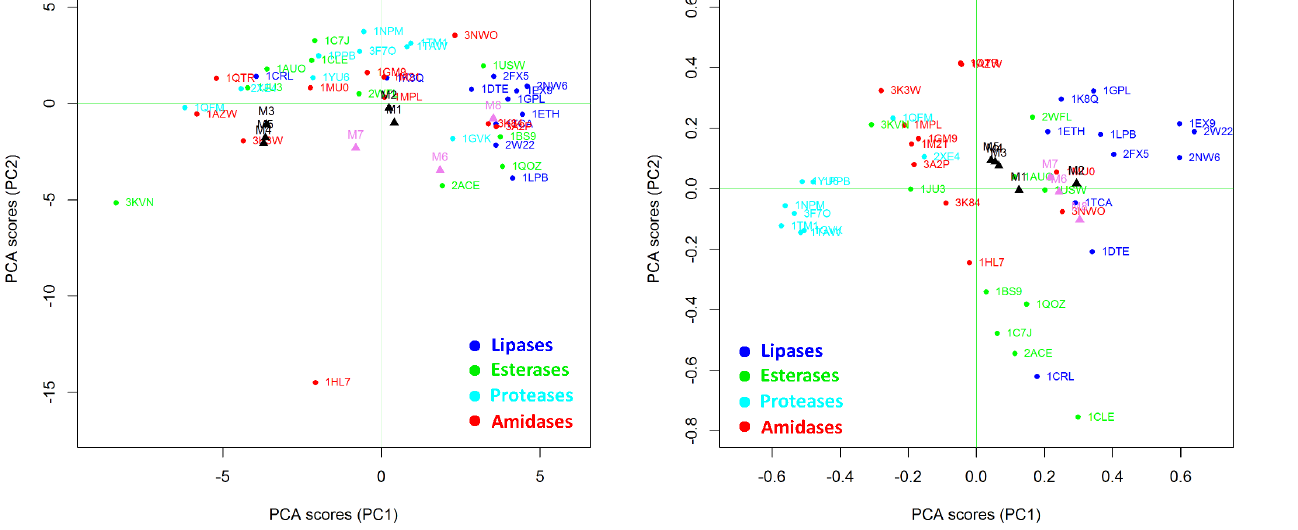
Figure 5. Unsupervised Pattern Cognition Analysis (UPCA) of BioGPS descriptors generated by H probe (shape). The enzymes are labelled according to their PDB code and colored as in figure 3. Improved mutants are highlighted in black triangles and poor mutants are in pink triangles.